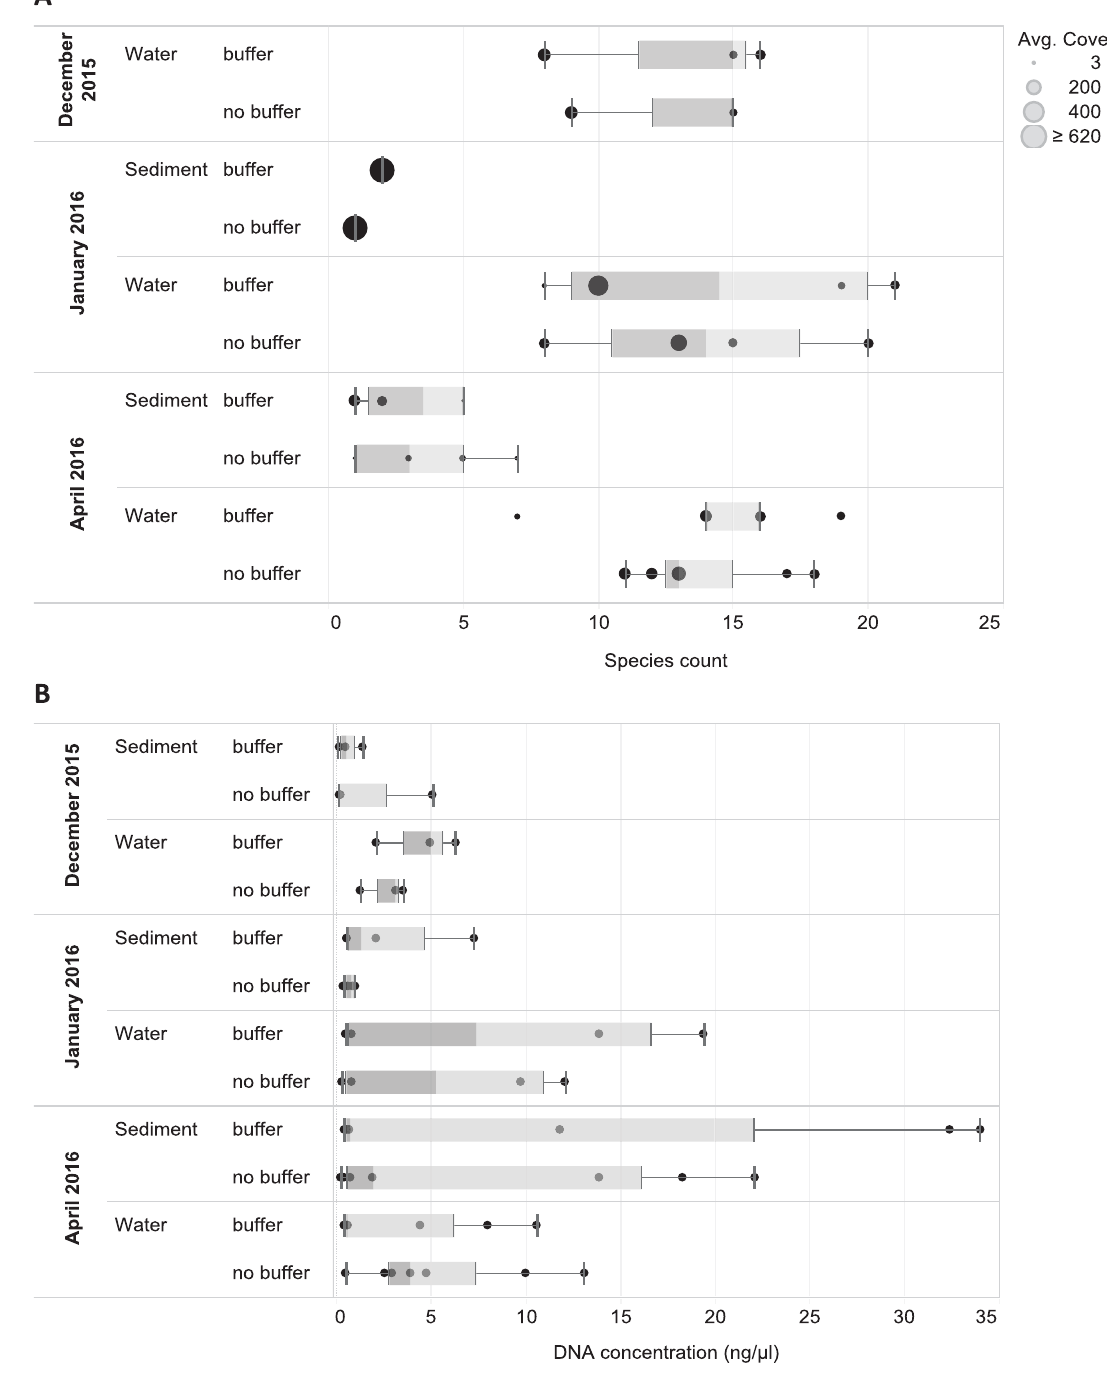
Fig 5. Species recovery and DNA concentration for each sampling event and treatment. A–Number of vertebrate species recovered for each sampling event and treatment (only PGM data for fishes are shown, circle size indicates average read count per sampling event). B–DNA concentration of sediment and water samples (one replicate per sampling event) measured on Qubit. Whiskers correspond to data within 1.5x of interquartile range (IQR).